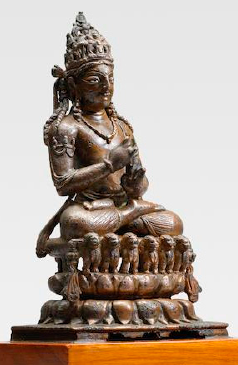
Figure 28. Vairocana in sambhogak ā ya form performing the bodhy ā gr ī mudr ā , eighth to ninth c. Swat. Copper alloy with silver inlay. Private collection. https://himalayanbuddhistart.wordpress.com/category/all/swat-valley-area/#jp-carousel-15485.